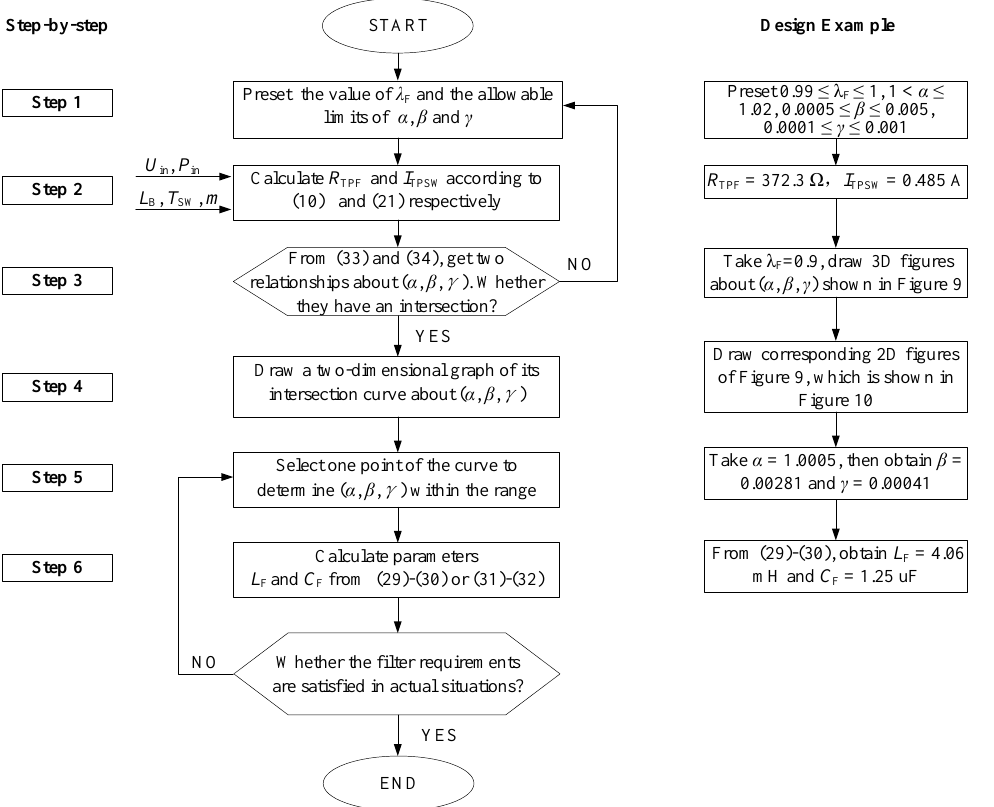
Figure 8. Design flow chart for LC low – pass filter.